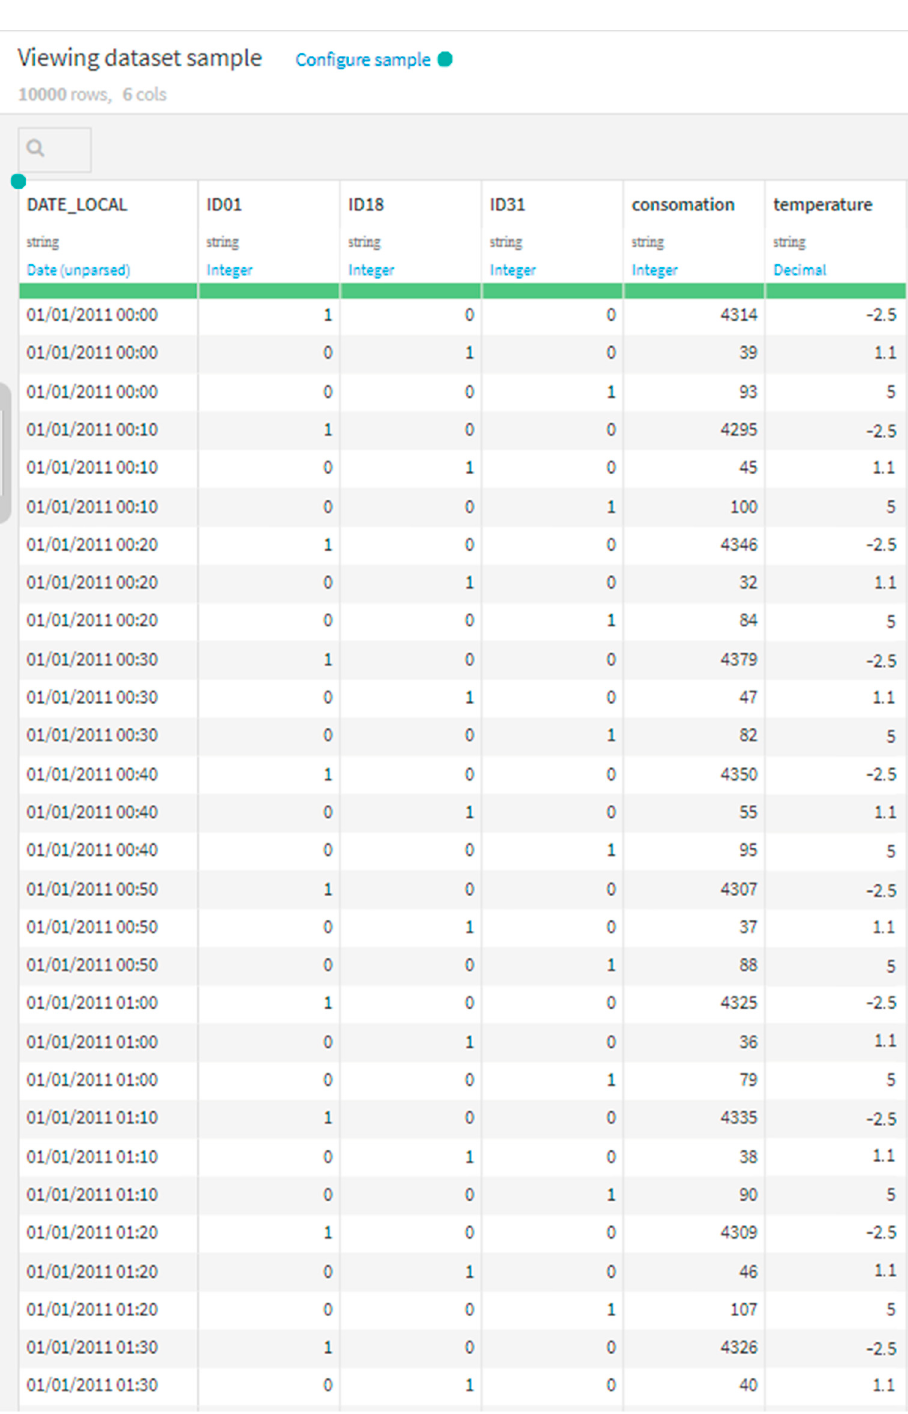
Figure 11. Extracted from data acquired.